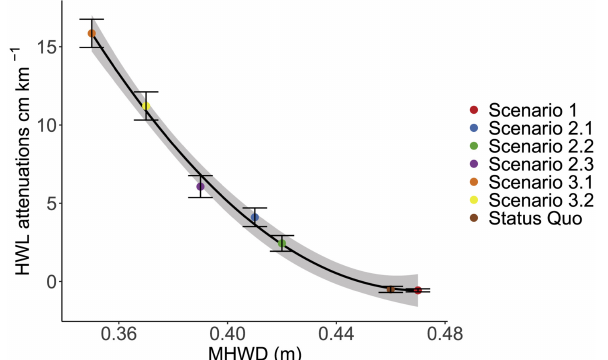
Figure 2. Modelled attenuation rates (cmkm − 1 ) for the MR Freis- ton Shore (for equinox spring tides) as a function of the mean high water depth (MHWD) for a series of design scenarios (Kiesel et al., 2020). Status quo: three breaches (ca. 50m each); scenario 1: com- plete removal of sea defence; scenario 2: one breach of 45m (sce- nario 2.1), 99m (scenario 2.2), and 30m (scenario 2.3); scenario 3: extended site area of 1416350m 2 instead of 650067m 2 (sce- nario 3.1) and 1124400m 2 instead of 650067m 2 (scenario